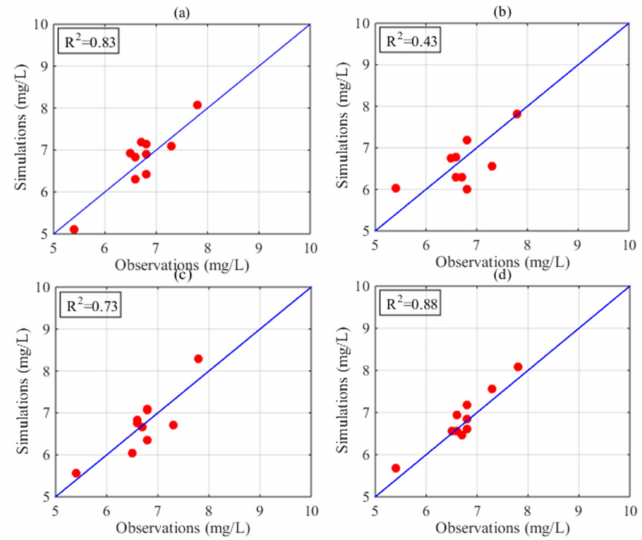
Figure 6. Observed and estimated DO in August from ( a ) cokriging, ( b ) the SVM, ( c ) HASM, and ( d ) HASM_MOD.